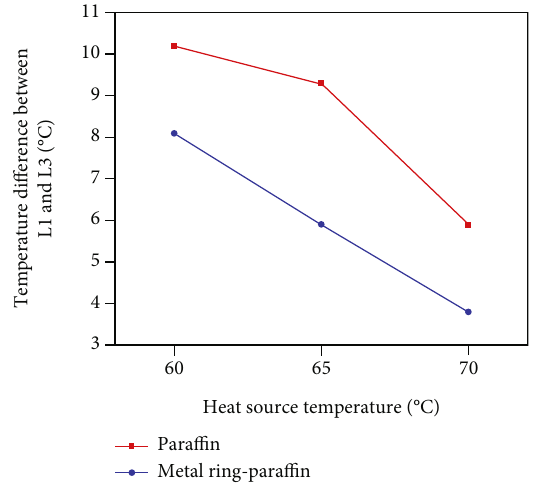
Figure 9: Variation diagram of temperature variation along the heat storage device ’ s horizontal axis.